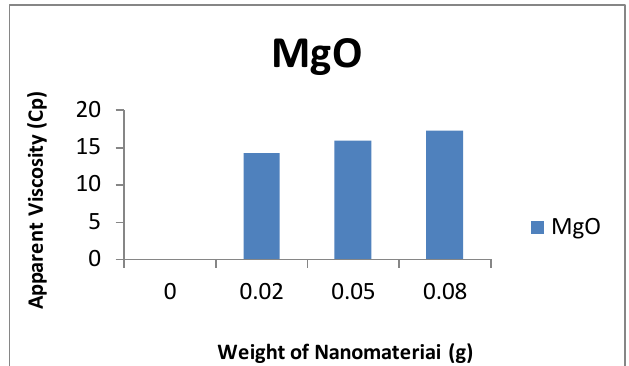
Figure8: Effect of Nano-magnesium oxide weight on apparent viscosity of attapulgite water-based